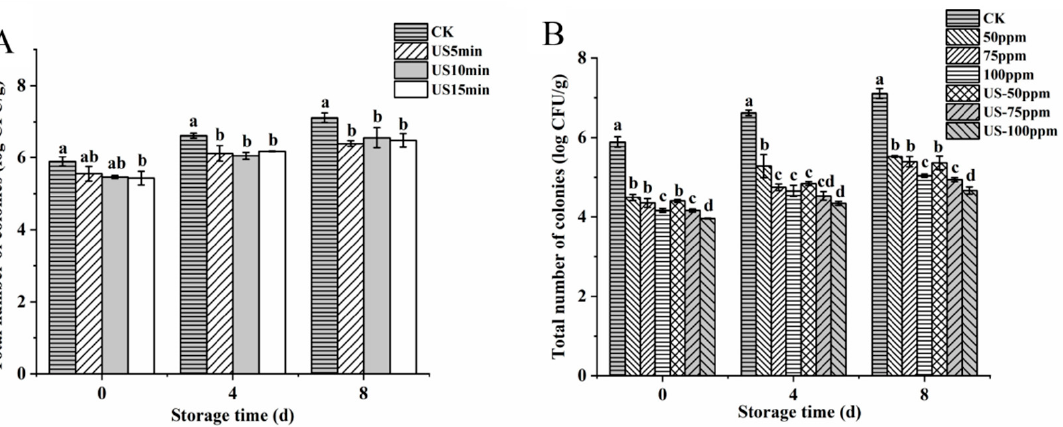
Figure 1. Effects of US treatment ( A ); NaClO and US-NaClO treatment ( B ) on total number of colonies of fresh-cut cucumber during storage. Different letters indicate significant differences among treatments at same storage time ( p < 0.05).